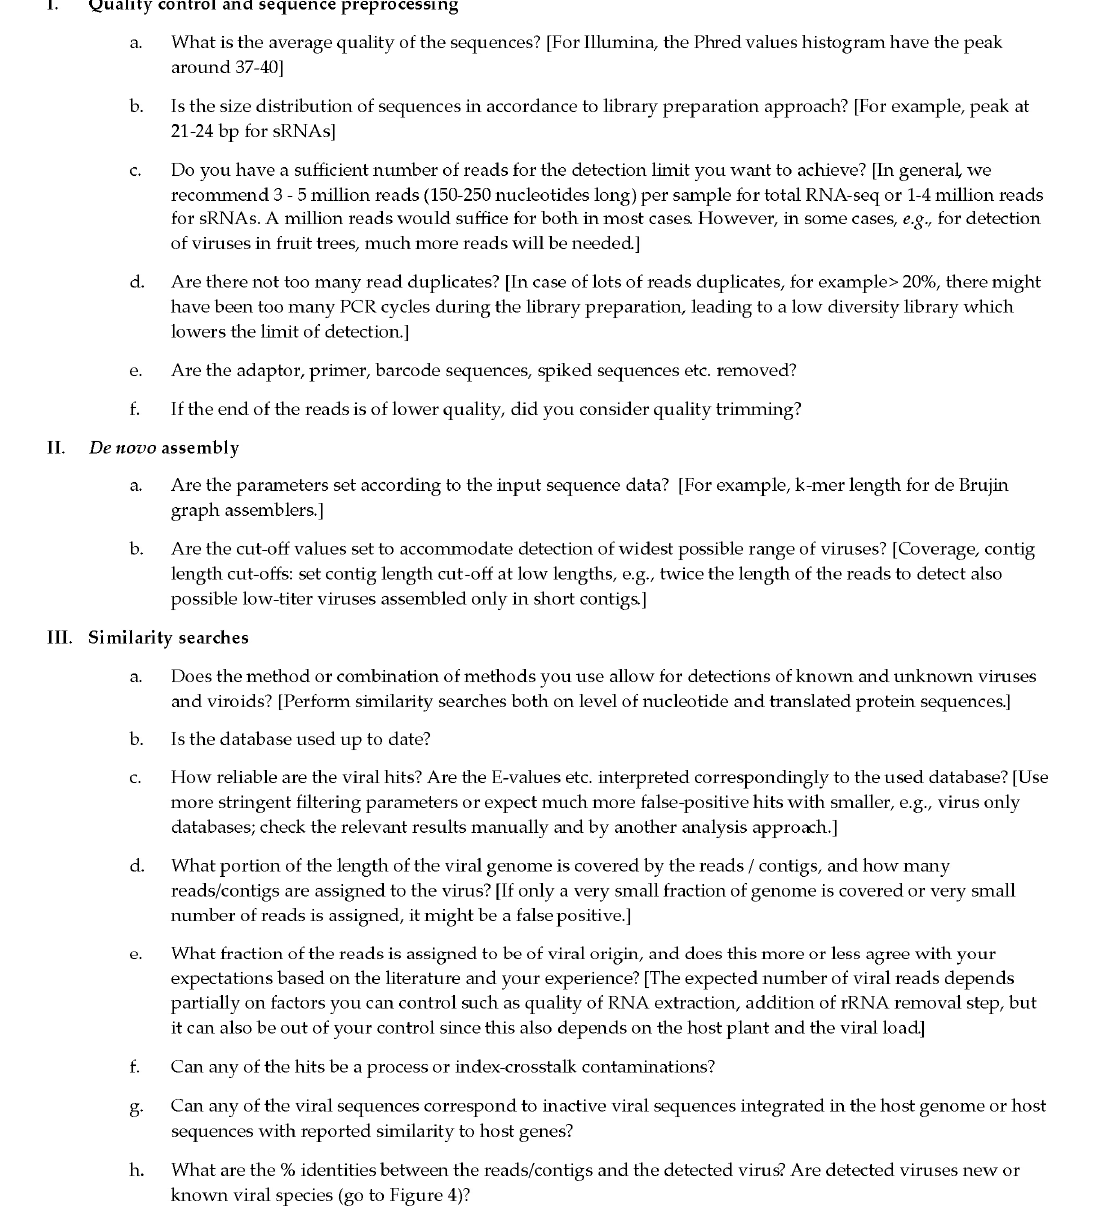
Figure 3. Checklist of the most important considerations to keep in mind during HTS data processing for detection of plant viruses.